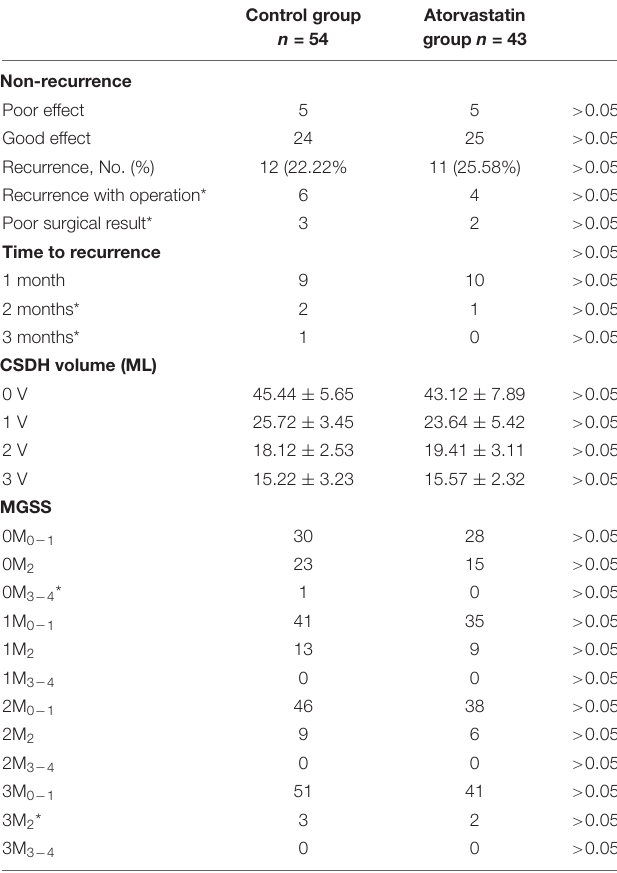
TABLE 5 | Follow-up effect analysis in the control and atorvastatin